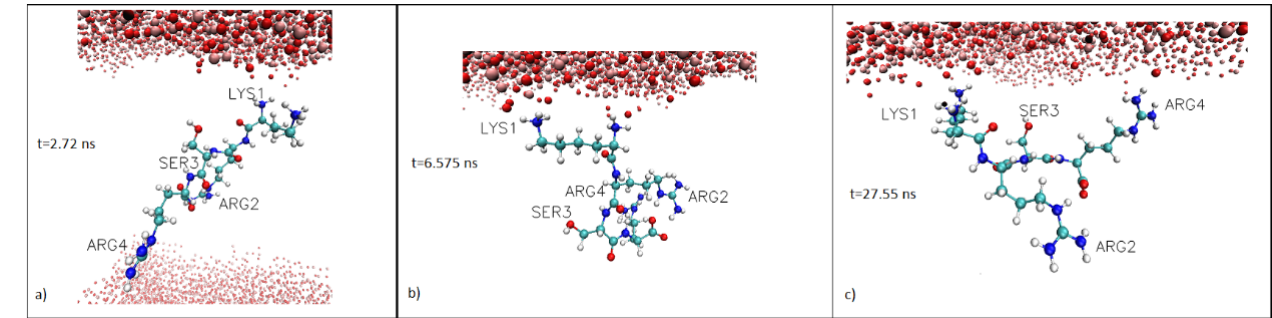
Figure 2. Snapshots from the simulation. ( a ) time t = 2.72 ns ( b ) time t = 8 ns; ( c ) t = 27.55 ns. The snapshots were made without the water molecules. Color code: oxygen, red; nitrogen, dark blue; carbon, cyan; titanium, ochre; hydrogen, gray. Visualization was done with VMD 1.9.3 in CPK representation.